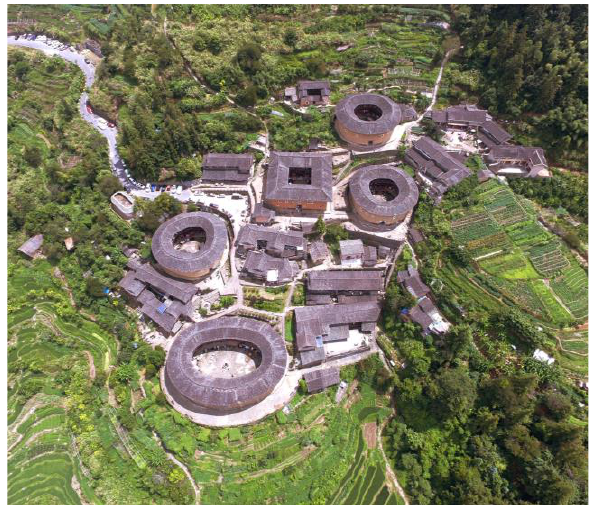
Figure 1. Tianluokeng settlement, Yongding